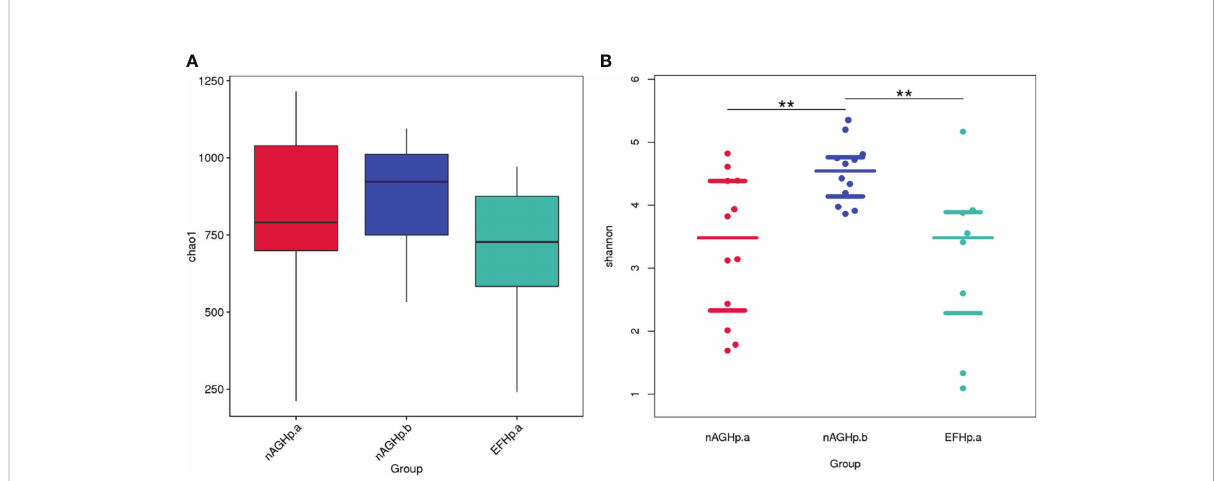
FIGURE 2 Comparisons of bacterial diversity index among groups. Chao1 index (A) , Shannon index (B) . ** P < 0.01. nAGHp.a, treatment-naïve patients with H. pylori infection; nAGHp.b, H. pylori -negative patients; EFHp.a, patients with refractory H. pylori infection.